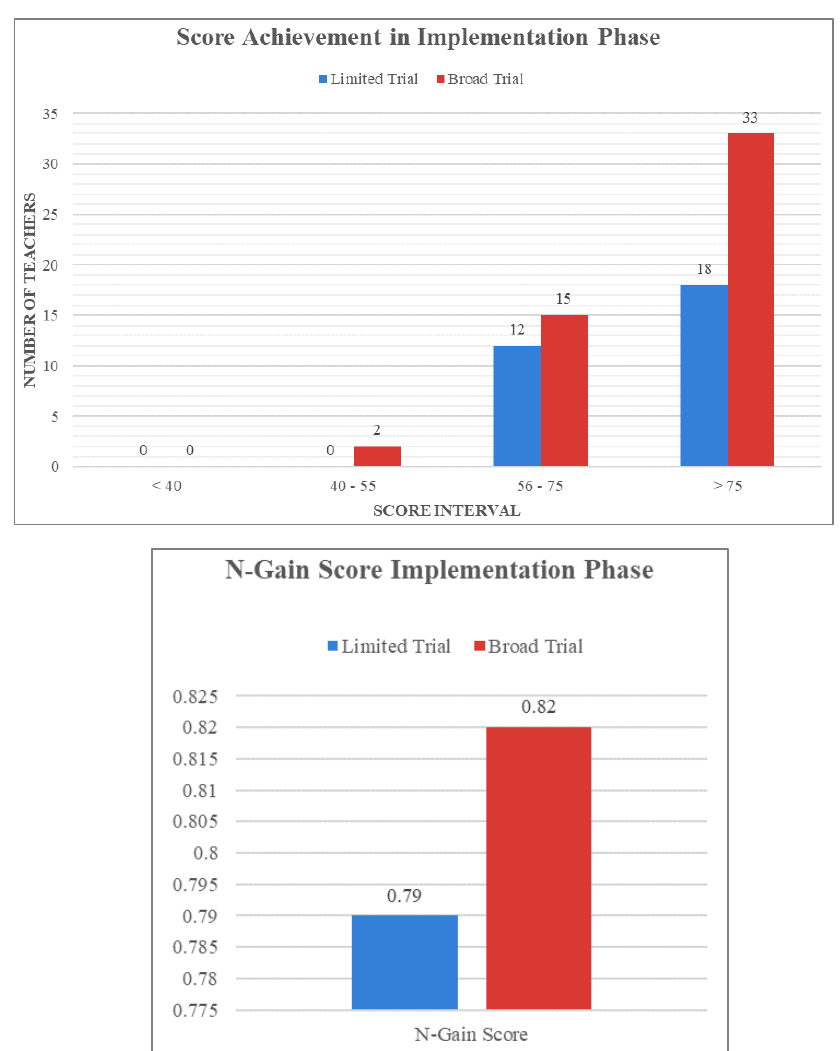
Figure 6. N-Gain Score in limited and broad trial